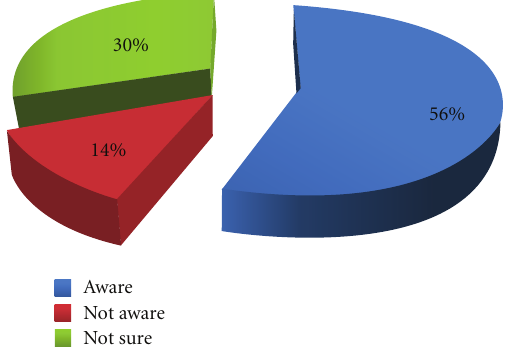
Figure 1: Average hand hygiene awareness among medical